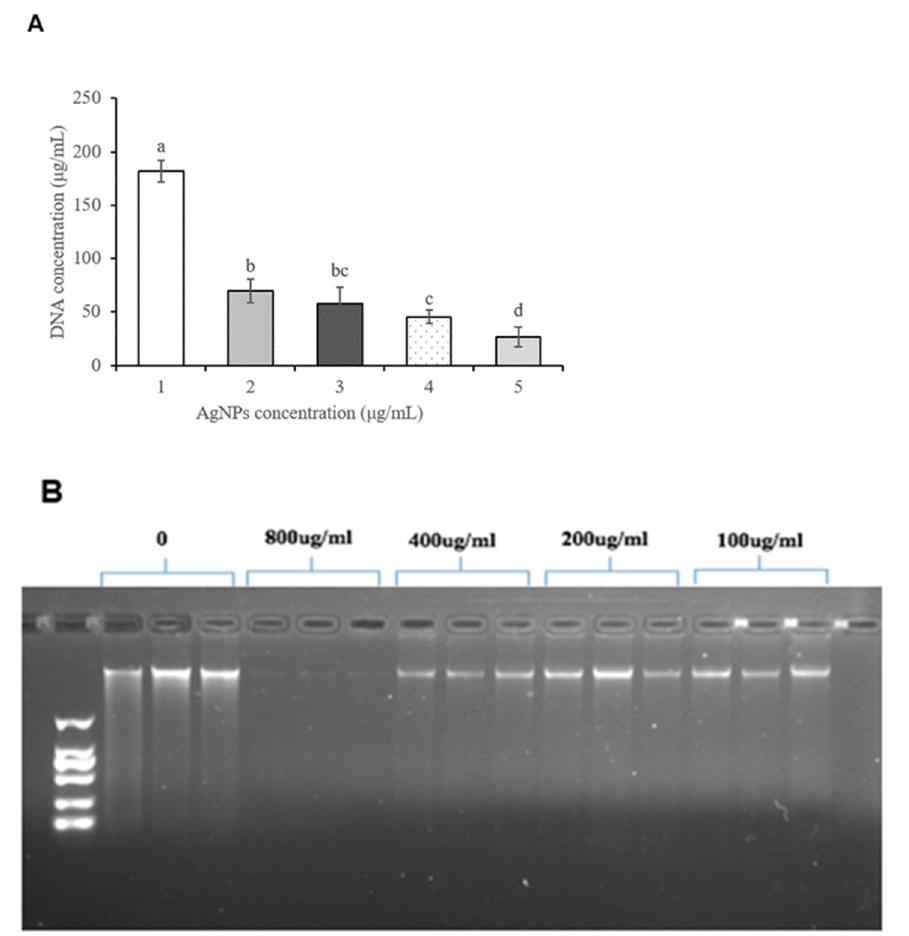
Figure 4. Effects of different treatments on the DNA concentration ( A ) and DNA gel electrophoresis map ( B ) of P. litchi . Lower-case letters indicate the significant differences ( p < 0.05) according to Duncan’s multiple range test.